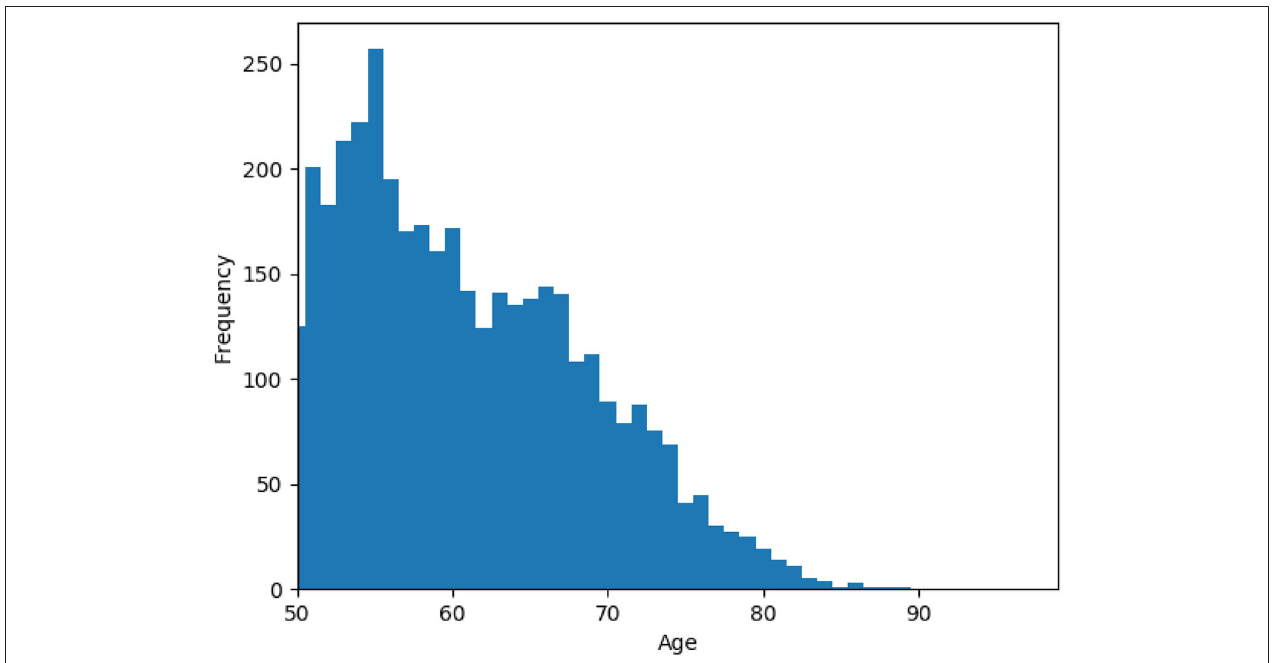
FIGURE 1 | Histogram of the age variable for samples at wave